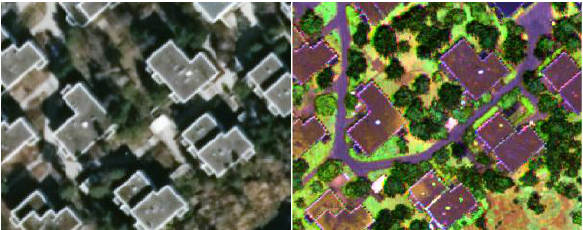
Figure 7. Aerial image ©NLS (left) and Titan intensity image